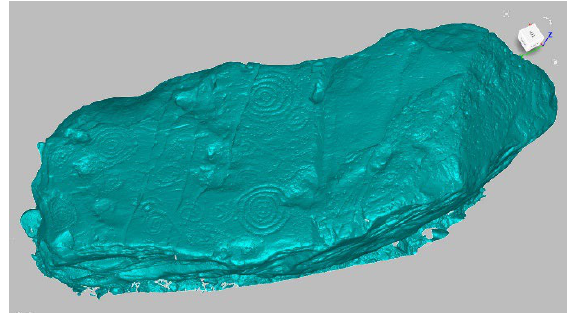
Figure 13. A photo-textured 3D mesh model generated using SD data